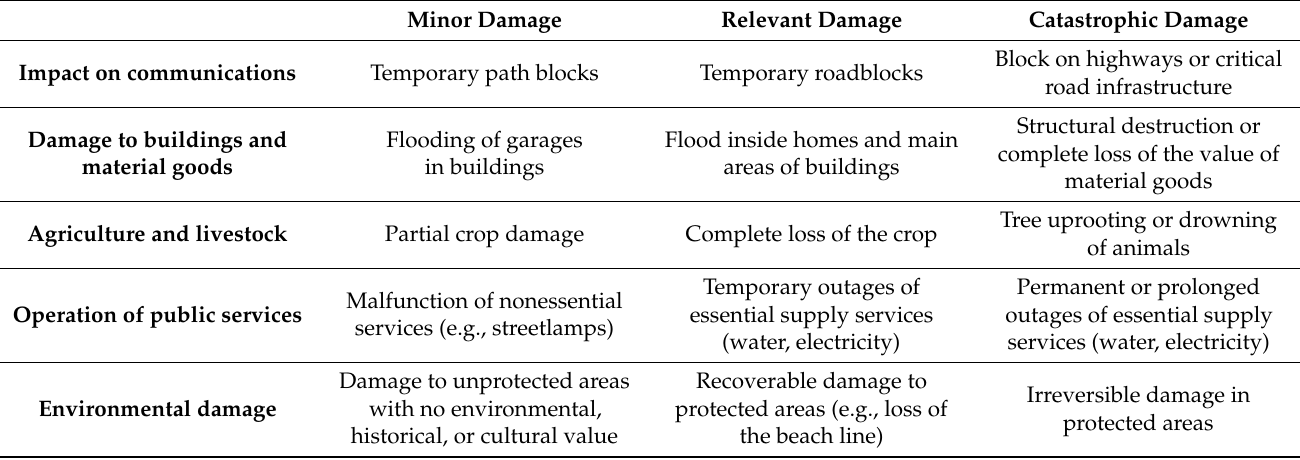
Figure 6. Detail of spatial distribution of the georeferenced database generated for damage. Source of data: Own elaboration from several emergency services of various municipalities, regional and state emergency service [31,32]. Table 1. 𝐼 𝐹𝐷𝑆 criteria for the level of significance of the damage.